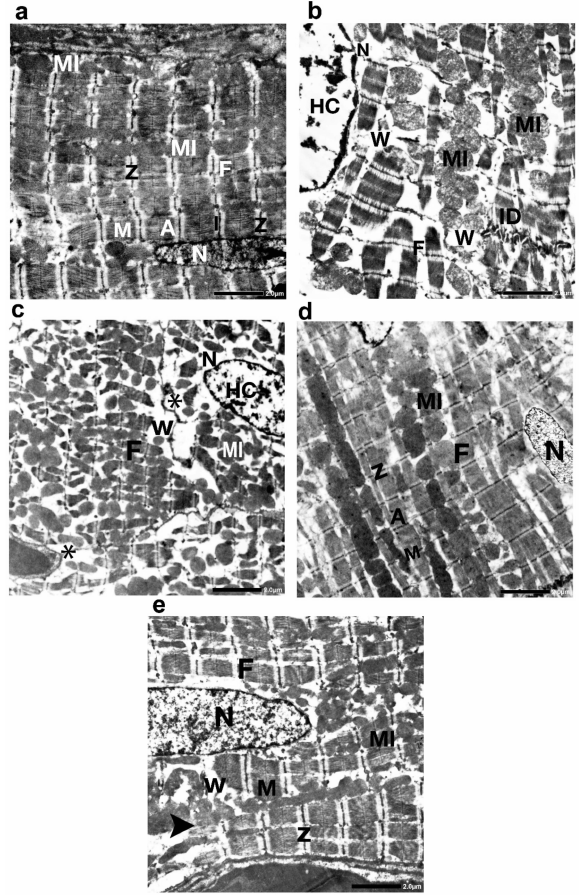
Figure 16. Representative electron micrographs of ultra-thin sections from the left ventricle of